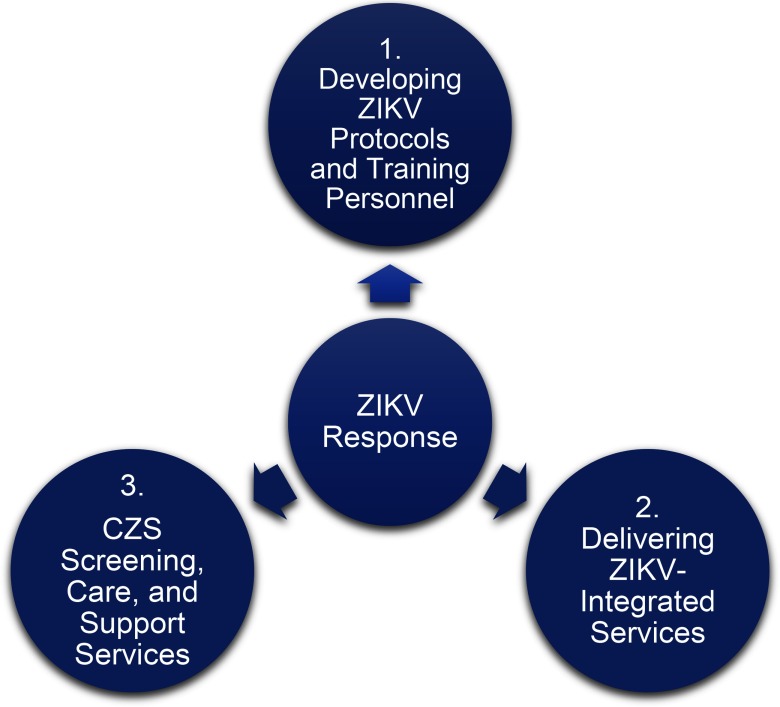
Programmatic Components of the IPPF SIFPO2 Zika Prevention Project in Latin America and the CaribbeanAbbreviations: CZS, congential Zika syndrome; IPPF, International Planned Parenthood Federation; SIFPO2, Support for International Family Planning Organizations 2 – Sustainable Networks Project; ZIKV, Zika virus.